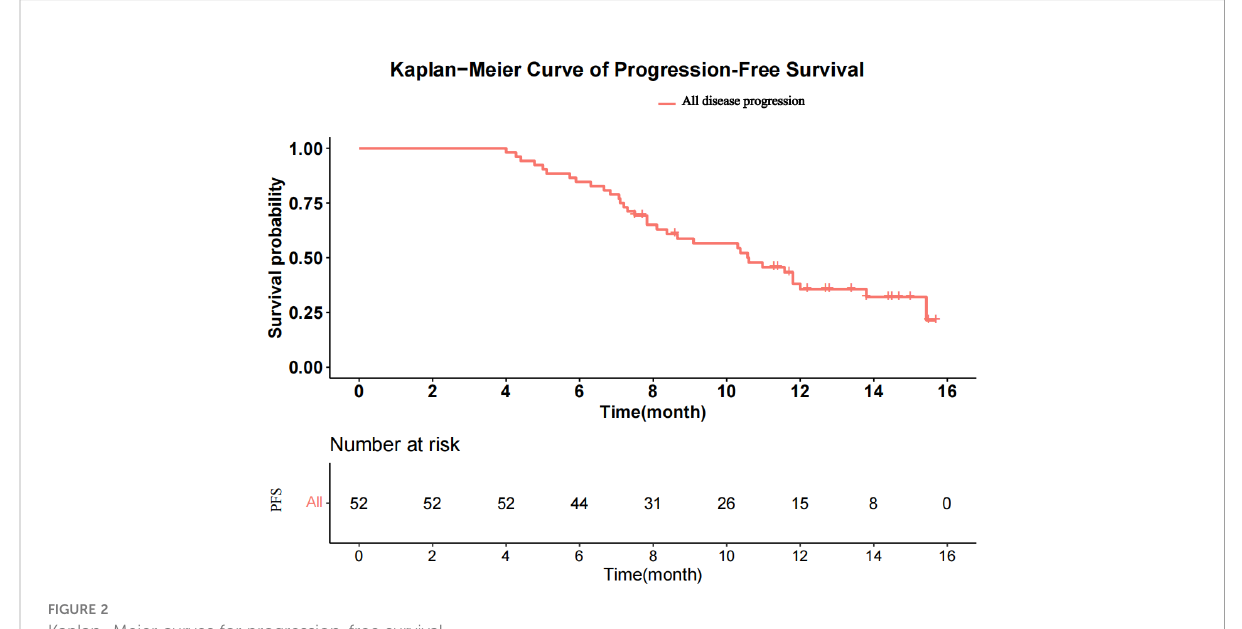
FIGURE 2 Kaplan – Meier curves for progression-free survival.